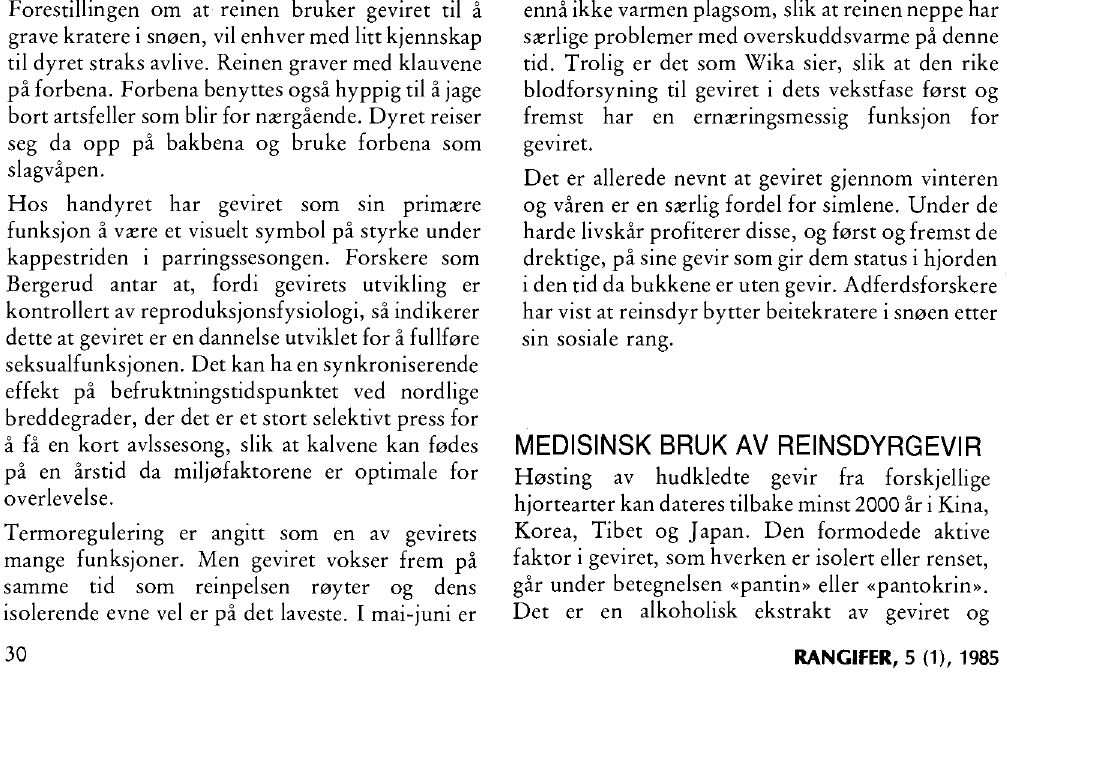
Fig. 4. Amputering av reingevir med spesialverktøy. I forgrening. Om høsten veier geviret 7 - 8